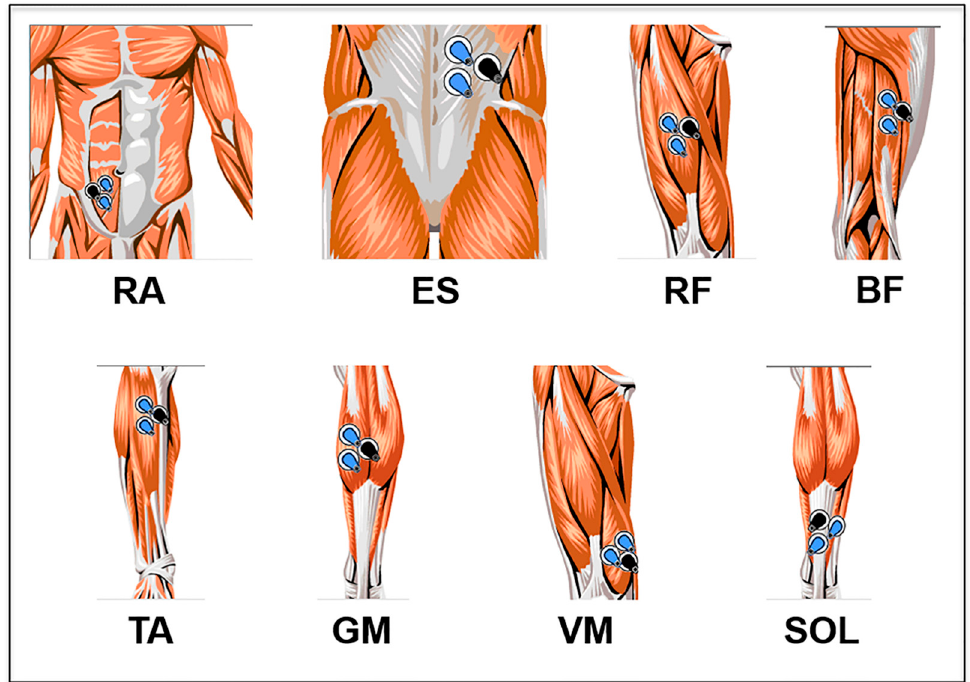
Figure 1. Positioning of the electrodes according to the analyzed muscle. Figure composed from images extracted from the Megawin 3.0.1 program. RA = rectus abdomini; ES = erector spinae; RF = quadriceps-rectus femoris; BF = biceps femoris (long head); TA = tibialis anterior; GM = gastrocnemius medialis; VM = vastus medialis; SO = soleus.